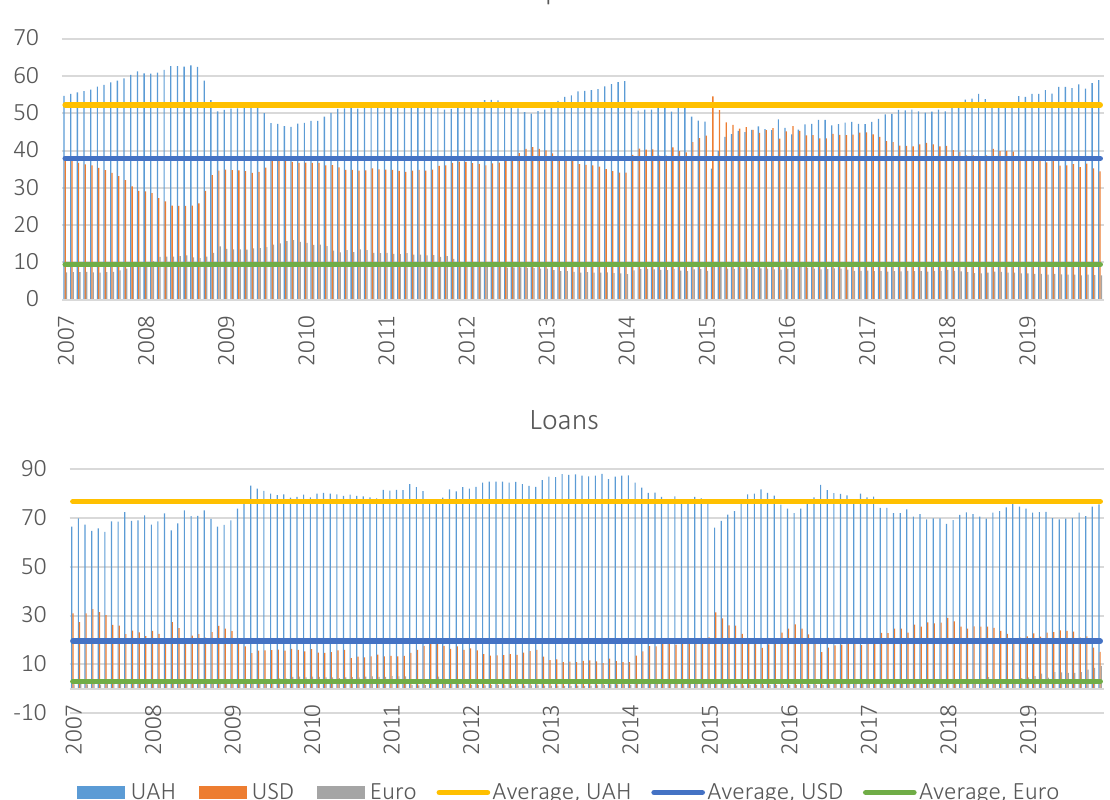
Figure 7. Dynamics of the structure of deposits and loans by